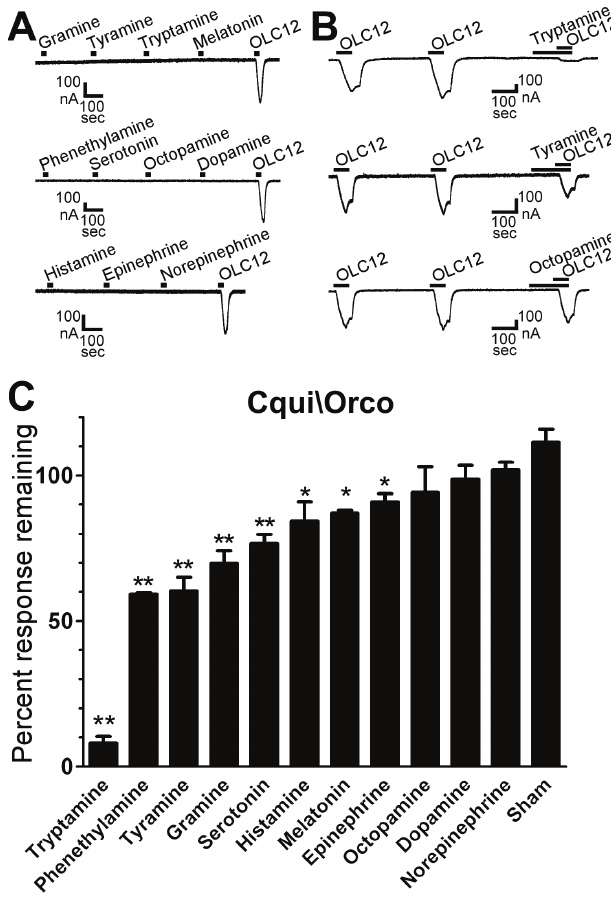
Figure 1. Structures of amines tested in this study. Electrophysiology and data capture Odorant and Orco ligand induced currents were recorded under two-electrode voltage clamp, using an automated parallel electrophysi- ology system (OpusExpress 6000A, Molecular Devices). Oocytes were perfused with ND96 (in mM: 96 NaCl, 2 KCl, 1 CaCl MgCl , 5 HEPES, pH 7.5). Orco ligands were prepared as 50 or 2 100 mM stock solutions in DMSO and then diluted into ND96 on the day of the experiment. Odorants were prepared as 100 mM stock solutions in DMSO and then diluted into ND96. Unless oth- erwise noted, applications were for 60 sec at a flow rate of 1.0 ml/min, with extensive washing in ND96 at 4.6 ml/min between applica- tions. Micropipettes were filled with 3 M KCl and had resistances of 0.2–2.0 M Ω . The holding potential was -70 mV. Current responses, filtered (4-pole, Bessel, low pass) at 20 Hz (-3 db) and sampled at 100 Hz, were captured and stored using OpusXpress 1.1 software (Molecular Devices).